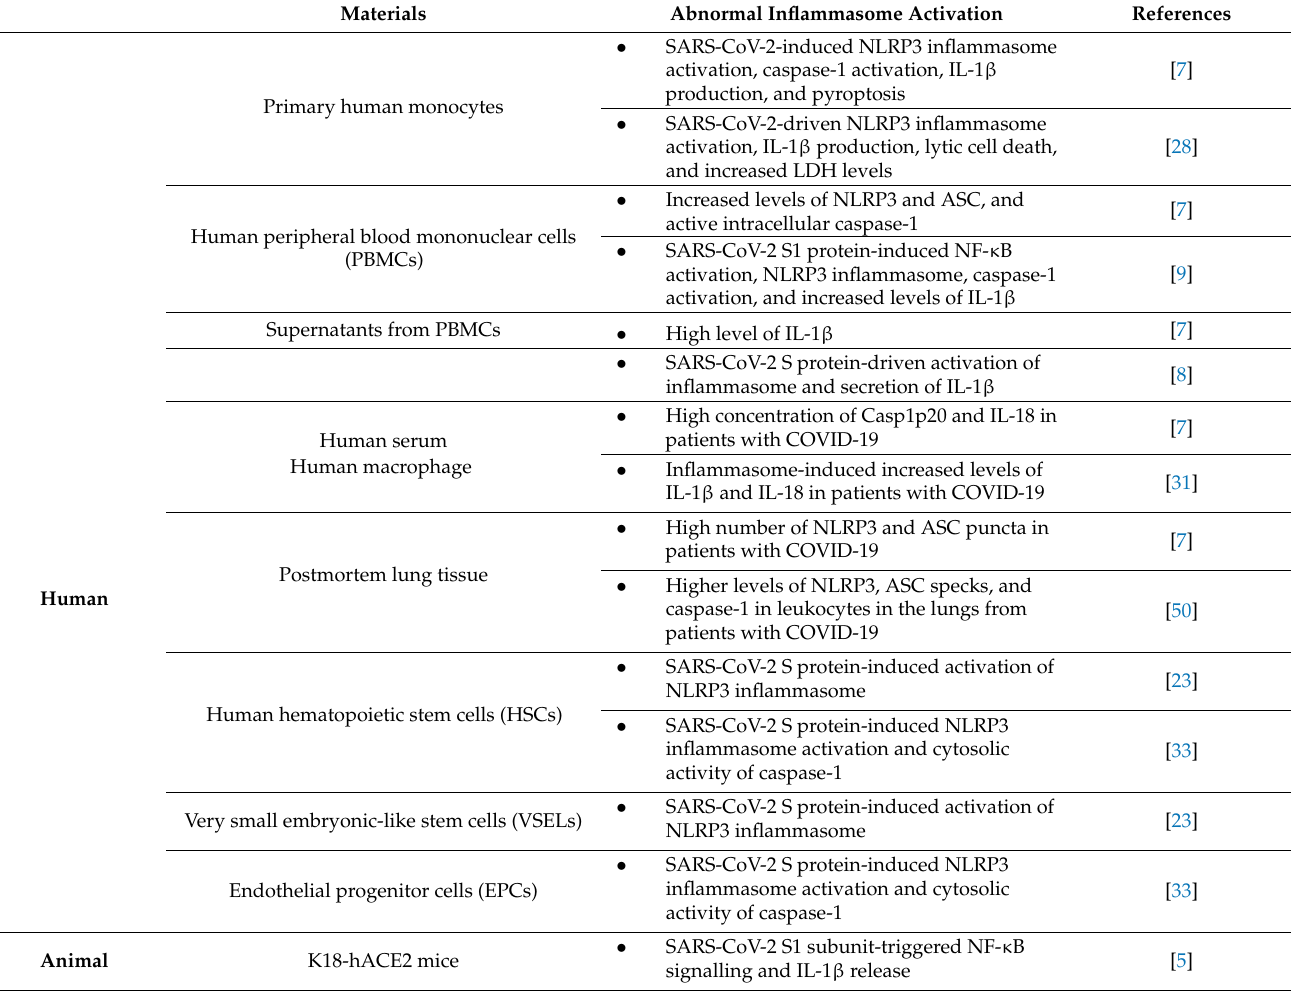
Table 1. Abnormal inflammasome activation after SARS-CoV-2